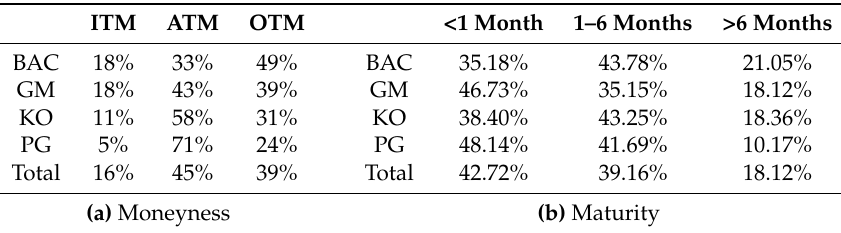
Table 2. Sample moneyness (a) and maturity (b)